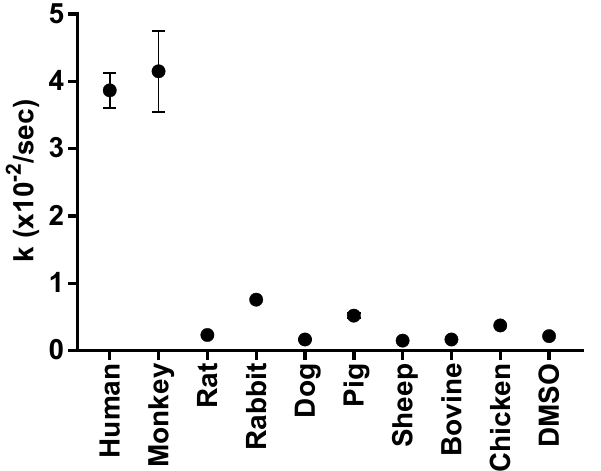
Figure 2. The rate constant of (EZ) -cyclobilirubin production from (EZ) -bilirubin (‘k’). The value of ‘k’ was calculated as the cyclobilirubin production rate divided by (EZ) -bilirubin at 3 min after irradiation. Each closed circle and error bar represent the mean ± SD. DMSO, dimethyl sulfoxide.